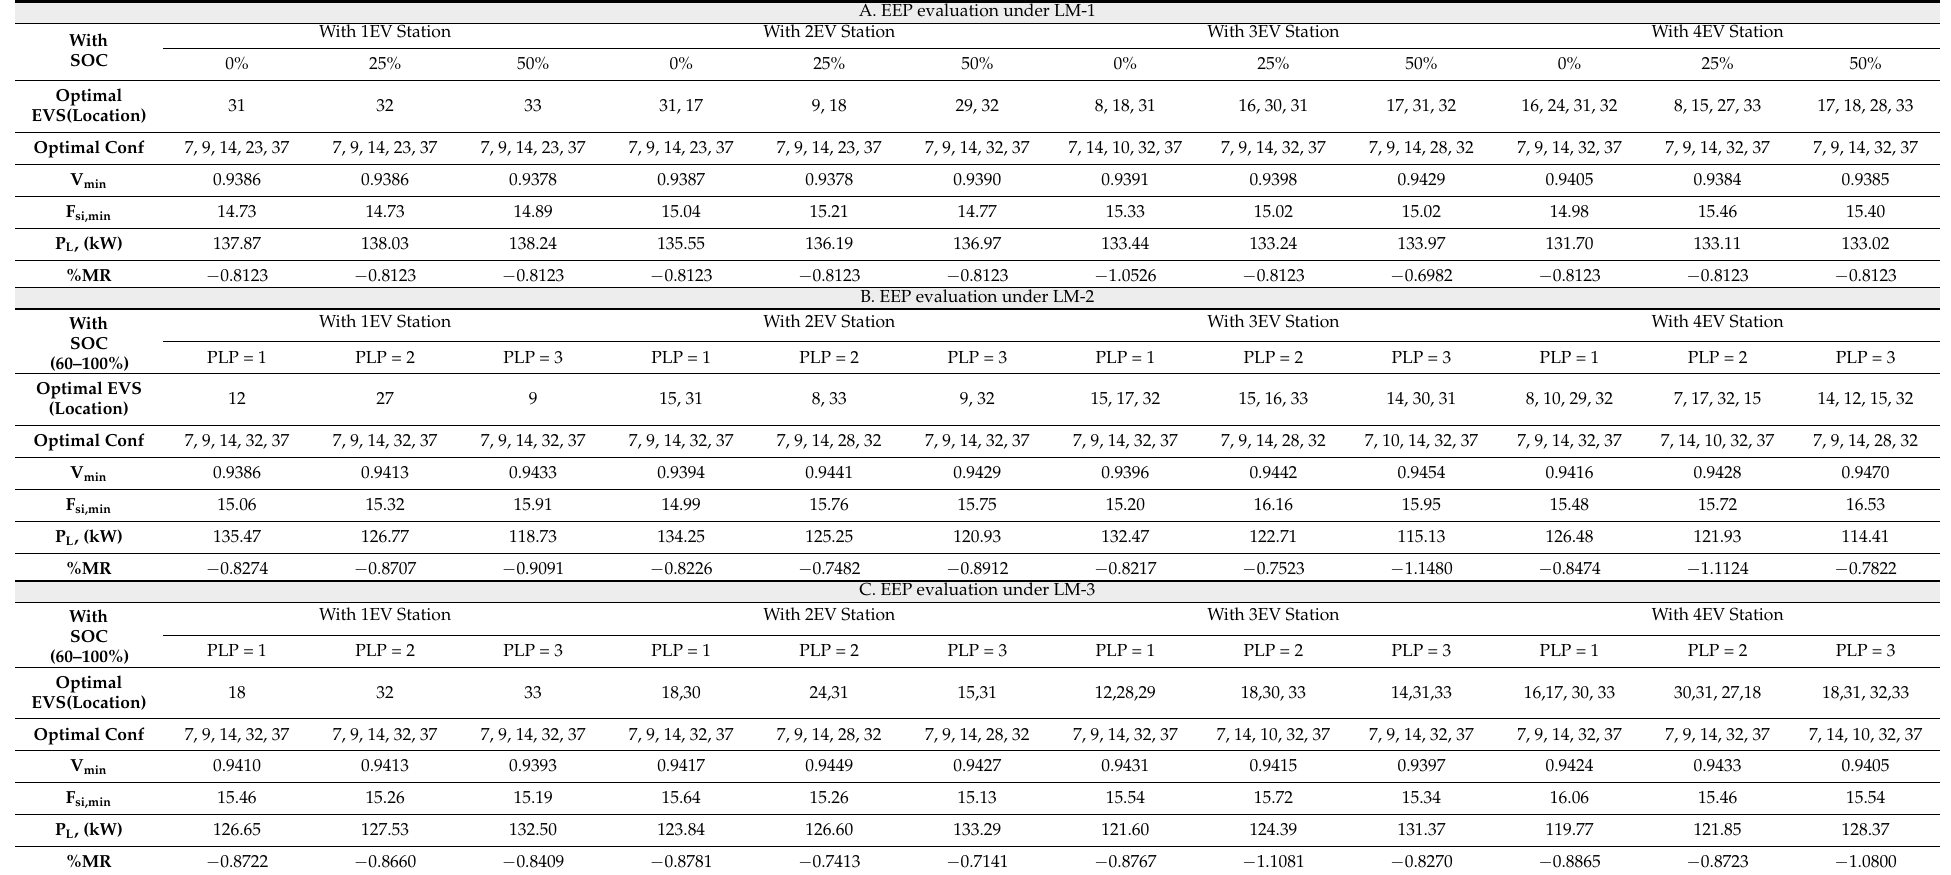
Table 8. EEP for Case-3 (when ESS works as a